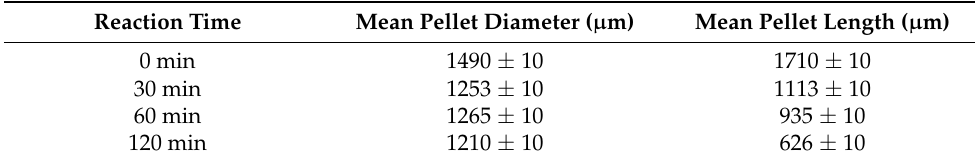
Table 1. Mean dimensions of the diameter and the lengths of the pellets at various dissolution times in peroxide solution 30%.